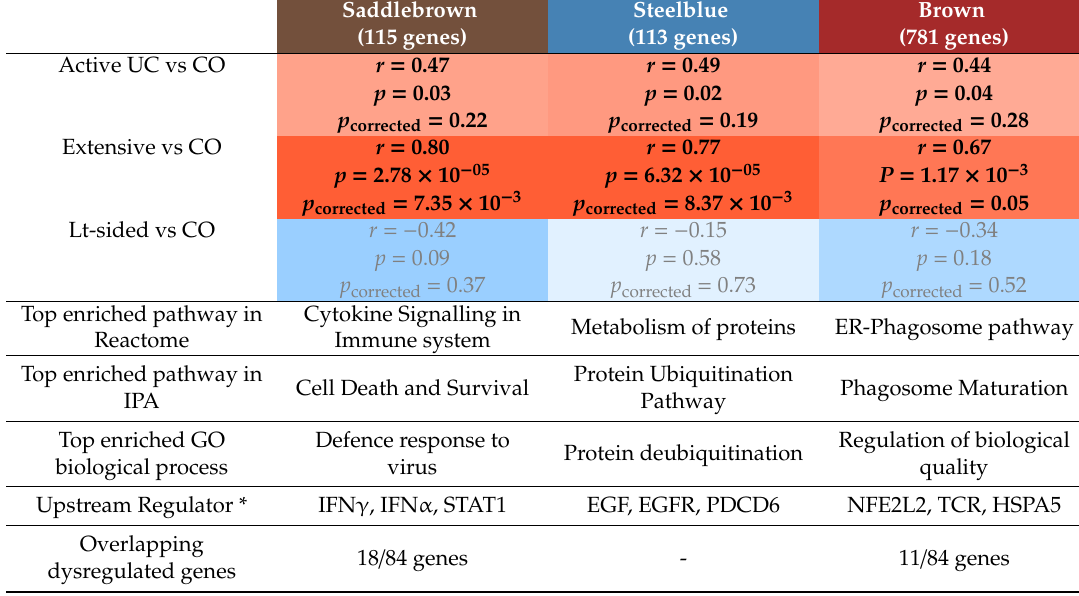
Correlationstrengthsrofeachmodulewerecalculatedforeachulcerativecolitissubgroupwithuncorrected / corrected p -values. The filled colours represent the strength of the association. A positive correlation (marked as red) means an upregulation in disease as compared to controls, while a negative correlation (marked as blue) refers to a downregulation in disease. The most highly scoring canonical pathways (according to p -value) according to Reactome, IPA, and GO enrichment analysis are given. * Top 3 ranked upstream regulators by IPA. UC, ulcerative colitis; CO, controls; Lt-sided, left-sided colitis as maximal disease extent; vs,